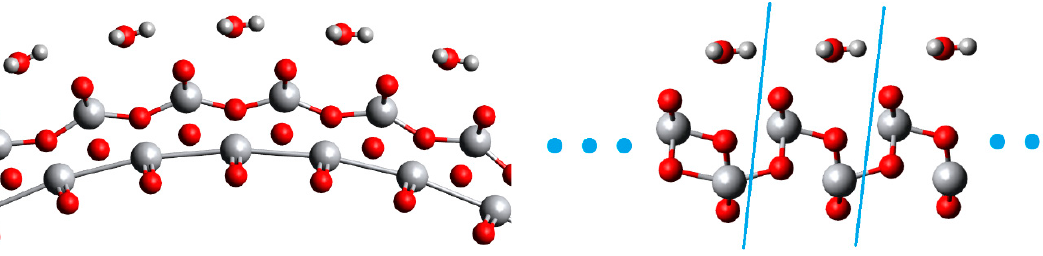
Figure 11. Fragment of a 6-layered (001) TiO 2 NT (0,40) and its 2D FVS model, with a multiplied unit cell. Water adsorption energies are shown for (001) ( n ,0) structures in Figure 12. Again, there is a curve for the reference NTs, a curve for each of the three FVS model variations, and the regular slab limit is also marked, which is − 0.72 eV in the (001) case.